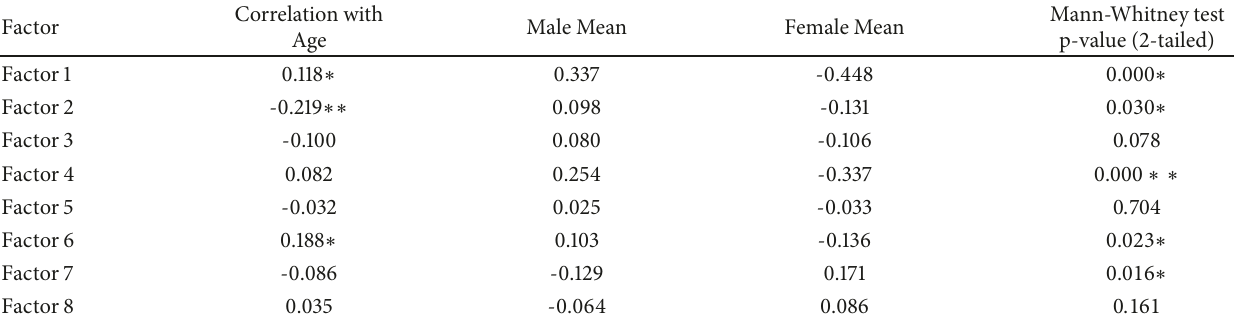
Table 3: Relationship of driving style factors with age and